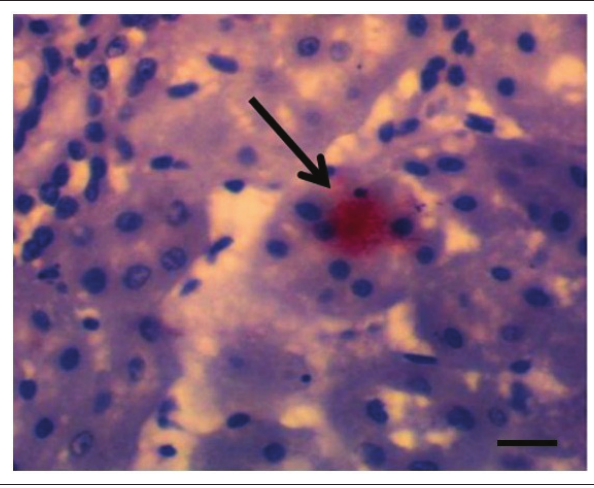
FIGURE 5: Kidney section of Hare showing strong immunoreactivity to Leptospira interrogans serovar bratislava antigen in the lumen of distal convoluted tubule (arrow).